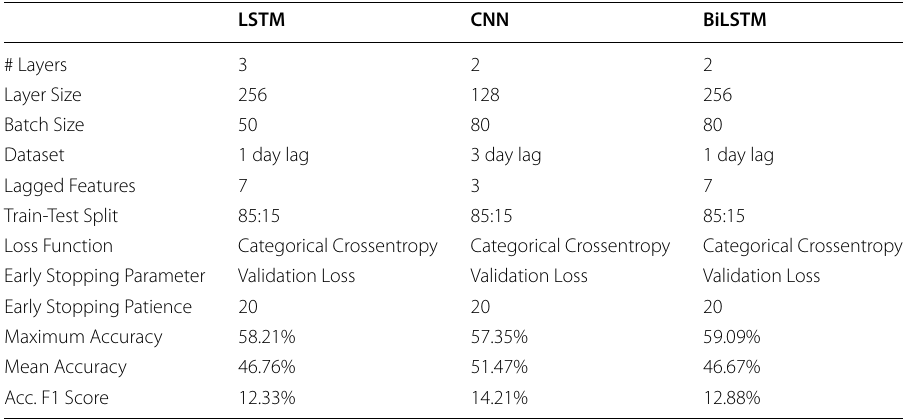
Table 4 Hyperparameters for the best models for predicting magnitude of change Acc. F1 Score - The sum of the individual F1 Scores of each